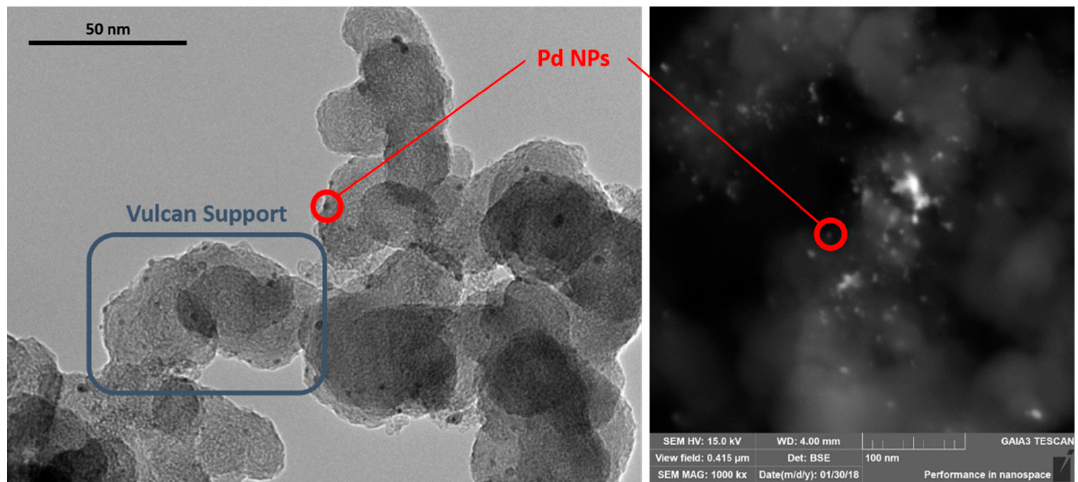
Figure1. TEM( left )andBackscatteredSEM( right )imagesofthePd / Celectrocatalyst. Thebackscattered Figure 1. TEM ( left ) and Backscattered SEM ( right ) images of the Pd/C electrocatalyst. The images show Pd NPs as black spots (TEM) and white spots (SEM with an inverted contrast in respect backscattered images show Pd NPs as black spots (TEM) and white spots (SEM with an inverted to TEM), while the grey haloes come from carbon contrast in respect to TEM), while the grey haloes come from carbon support.